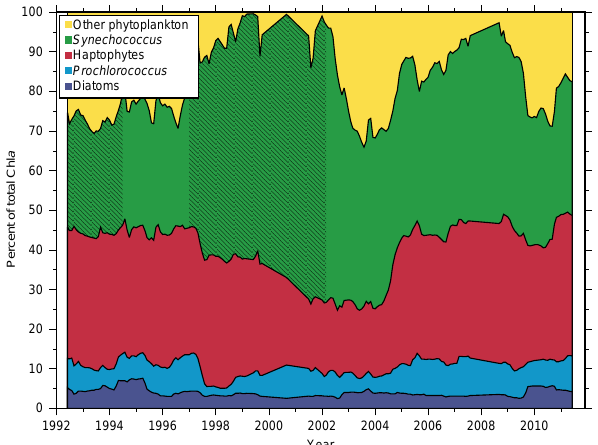
Figure 2. Percent of Chl a from main phytoplankton groups at BATS from 1992 to 2012 in the top 30m of the water column derived from signature pigment and Chl a total concentrations, de- seasonalized with a 1-year boxcar filter (purple is diatoms, blue is Prochlorococcus , red is haptophytes, green is Synechococcus , yel- low is other phytoplankton). Hatched area indicates missing pig- ment data for Synechococcus .